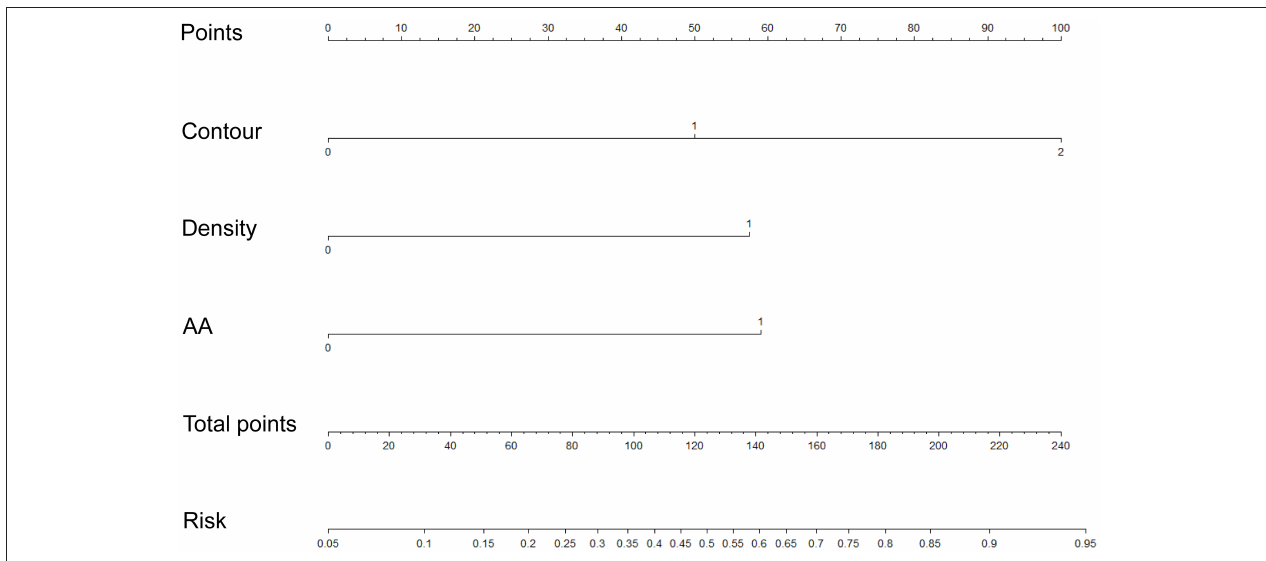
FIGURE 5 | Construction of an individualized imaging nomogram in the training cohort incorporated three independent predictors consisting of contour, density, and AA.